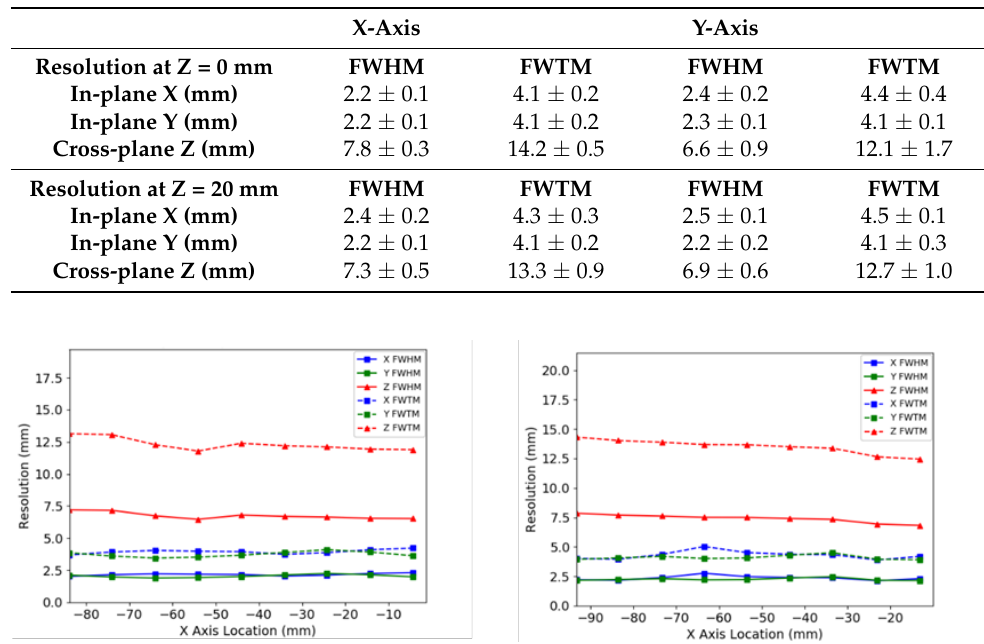
Table 1. Average values of MLEM spatial resolution in terms of the X, Y, and Z FWHM and FWTM for a detector-head separation of 80 mm.